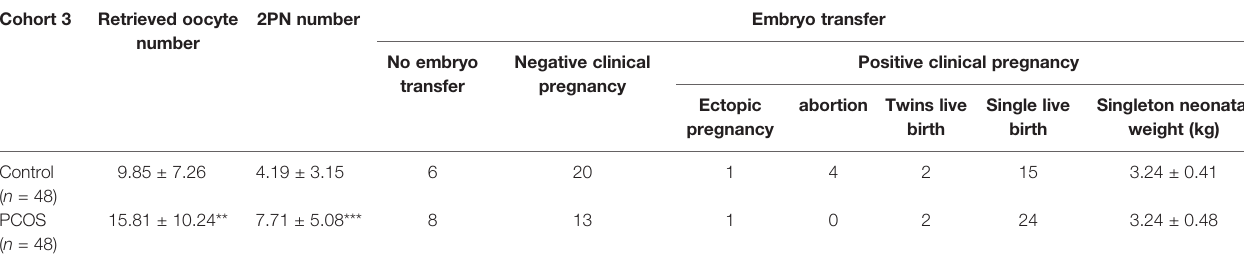
TABLE 2 | Retrieved oocyte number, embryo development, and embryo transfer